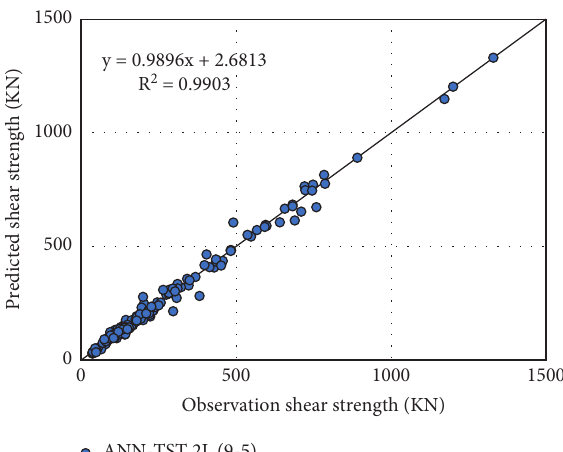
Figure 5: Target (experimental) versus predicted values of shear strength for ANN-TST 2L (9-5) model using training data.